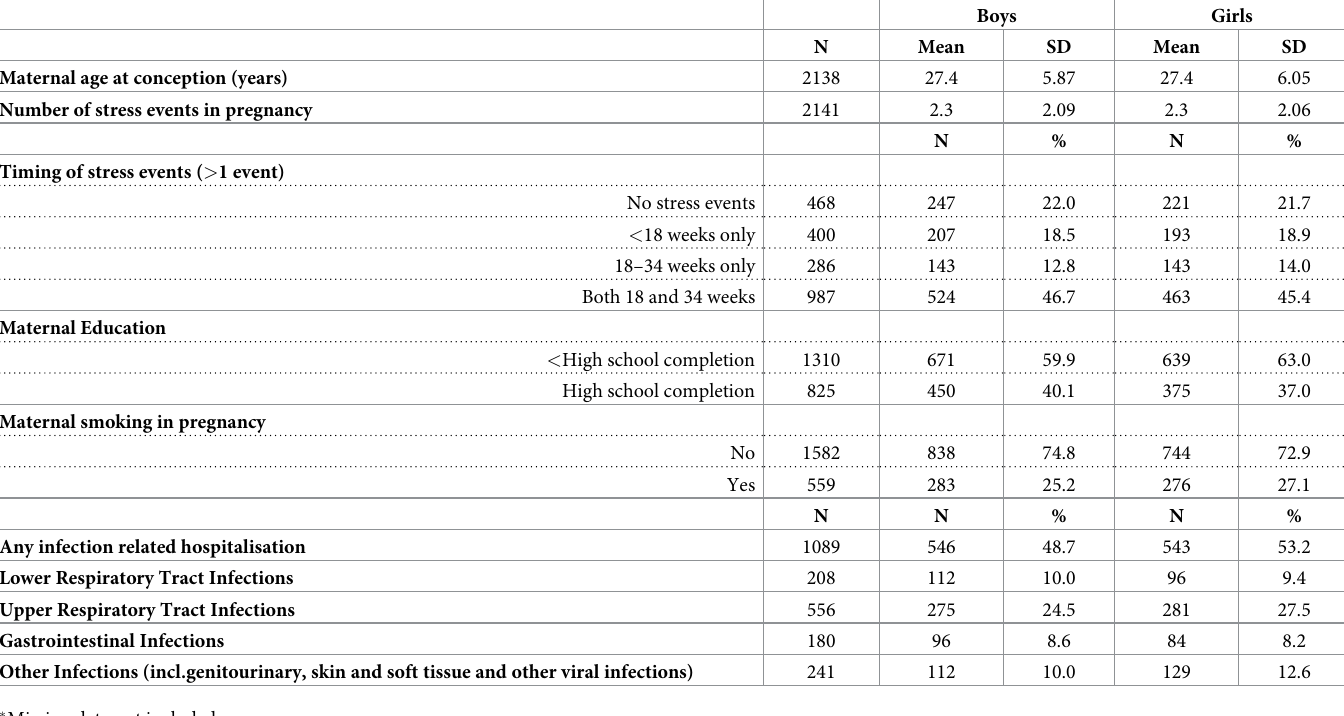
Table 1. Frequency data for study variables, stress events and infection-related hospitalisations by sex (N =